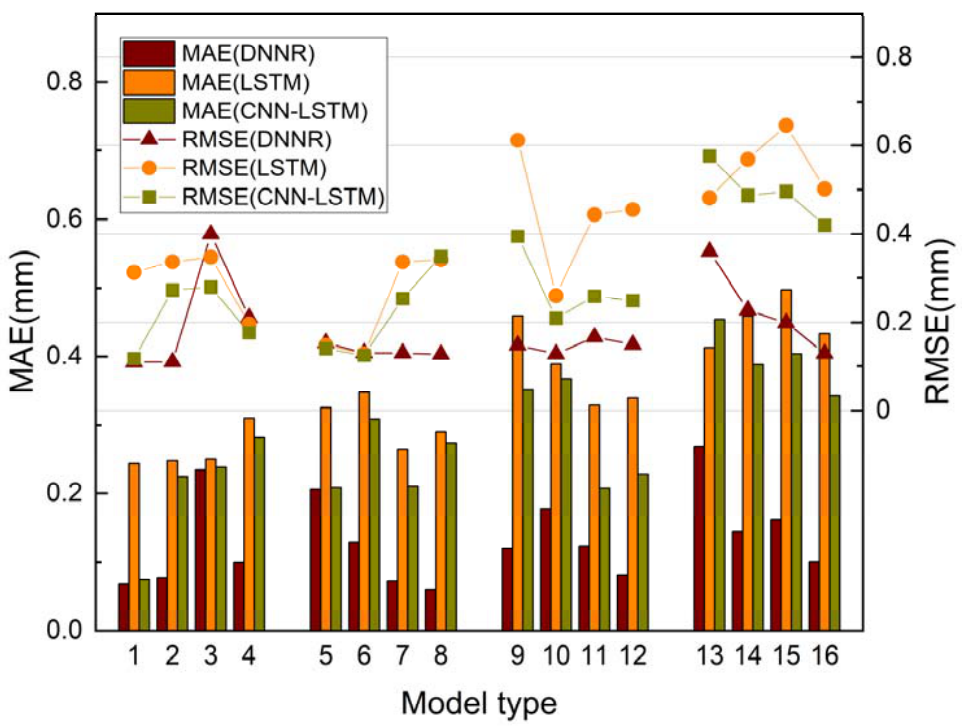
Figure 22. The RMSE and MAE of predictive daily ET o and actual ET o for Greenhouse B under four forecast time points.